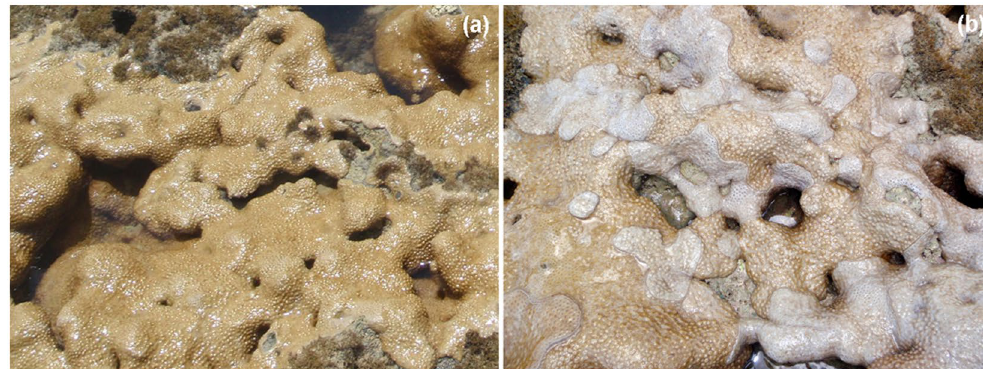
Figure 1. Representative images of Palythoa caribaeorum colonies sampled in the present study. ( a ) Healthy Palythoa caribaeorum colonies. ( b ) Colonies of P . caribaeorum experiencing bleaching. Both colonies were photographed on reefs of Porto de Galinhas Beach, PE, Brazil ( Photo by Dr. C. D. Perez’s research group